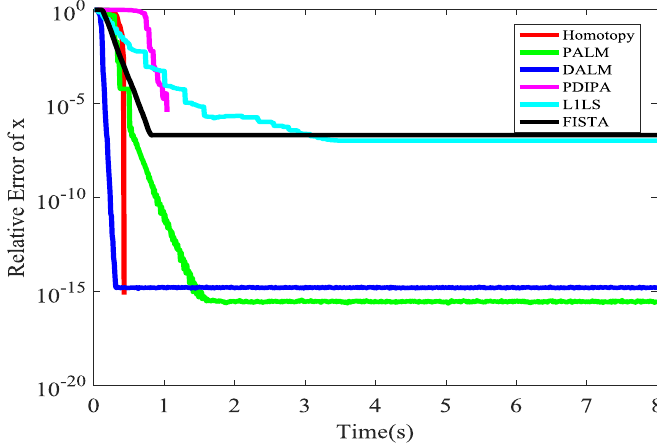
Figure 13. The time of different kernel L1 optimization. Table 2. Comparison of times.